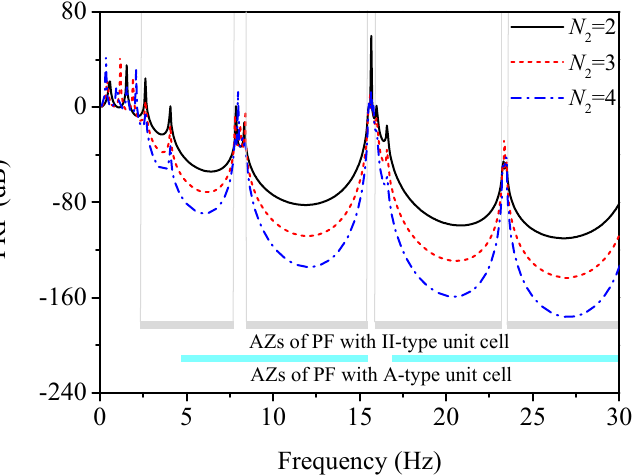
Figure 10. FRFs of the combined layered periodic foundation with two Ι –type unit cells and various numbers of ΙΙ –type unit cells.